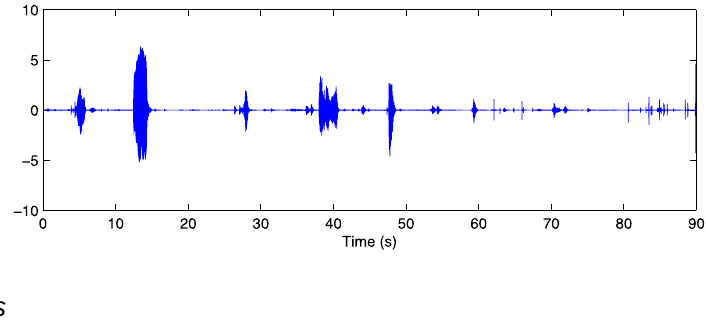
Figure 12. 90 s speech recording obtained with the BRVAR909 smartphone for one of the subjects of the experiments.